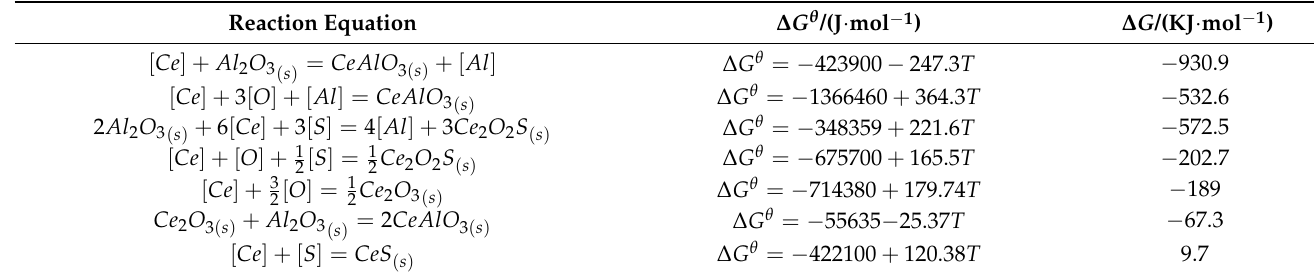
Table 4. Gibbs free energy of formation of rare earth inclusions in tested steel at 1873